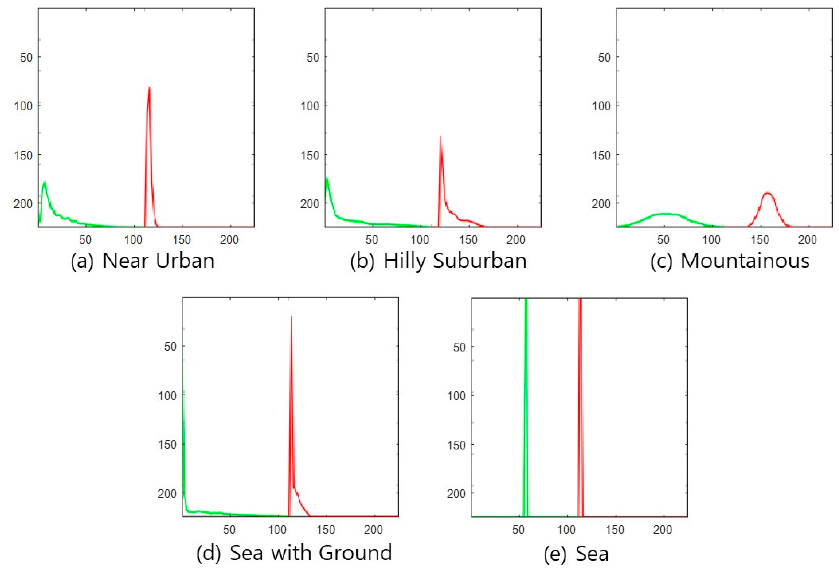
Figure 5. Example of a combination of absolute and relative-altitude PMF for each topography class.